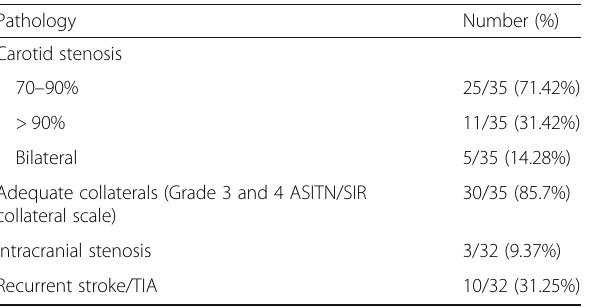
Table 2 Different stroke presentation, collateral state, intracranial stenosis, and carotid stenosis grading Pathology